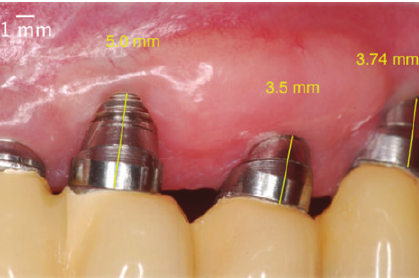
Figure 5: Postoperative aspect 7 days after surgery.